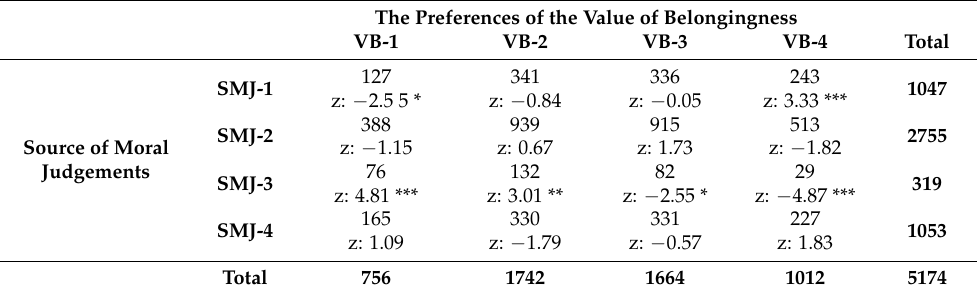
Table 4. Relationship between the preference for the value of belongingness and source of moral judgements (SMJ). The Preferences of the Value of Belongingness VB-1